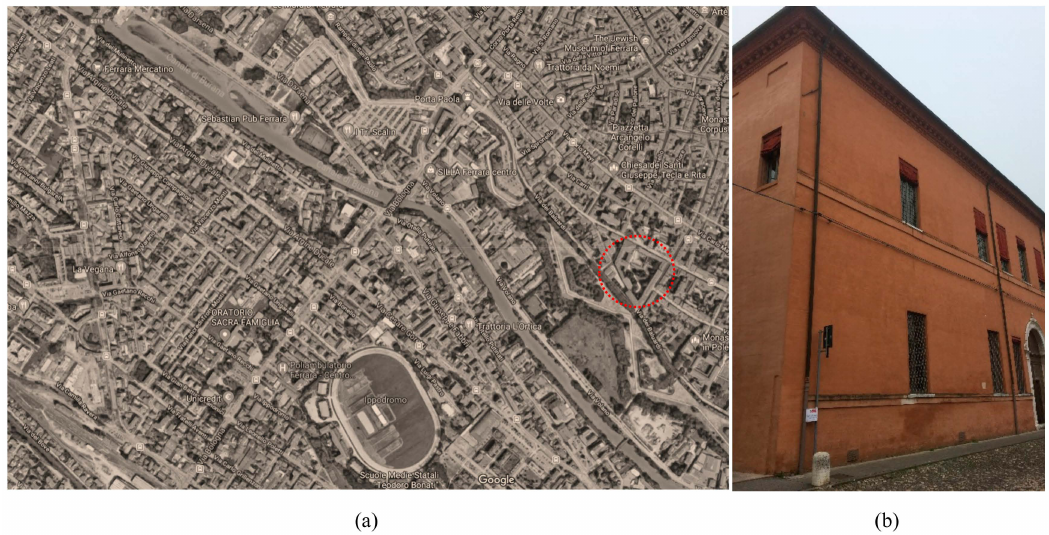
Figure 5. ( a ) Site plan of the Palazzo Tassoni Estense (Google Maps (2019)); ( b ) façade of the Palazzo Tassoni Estense (photo by M.